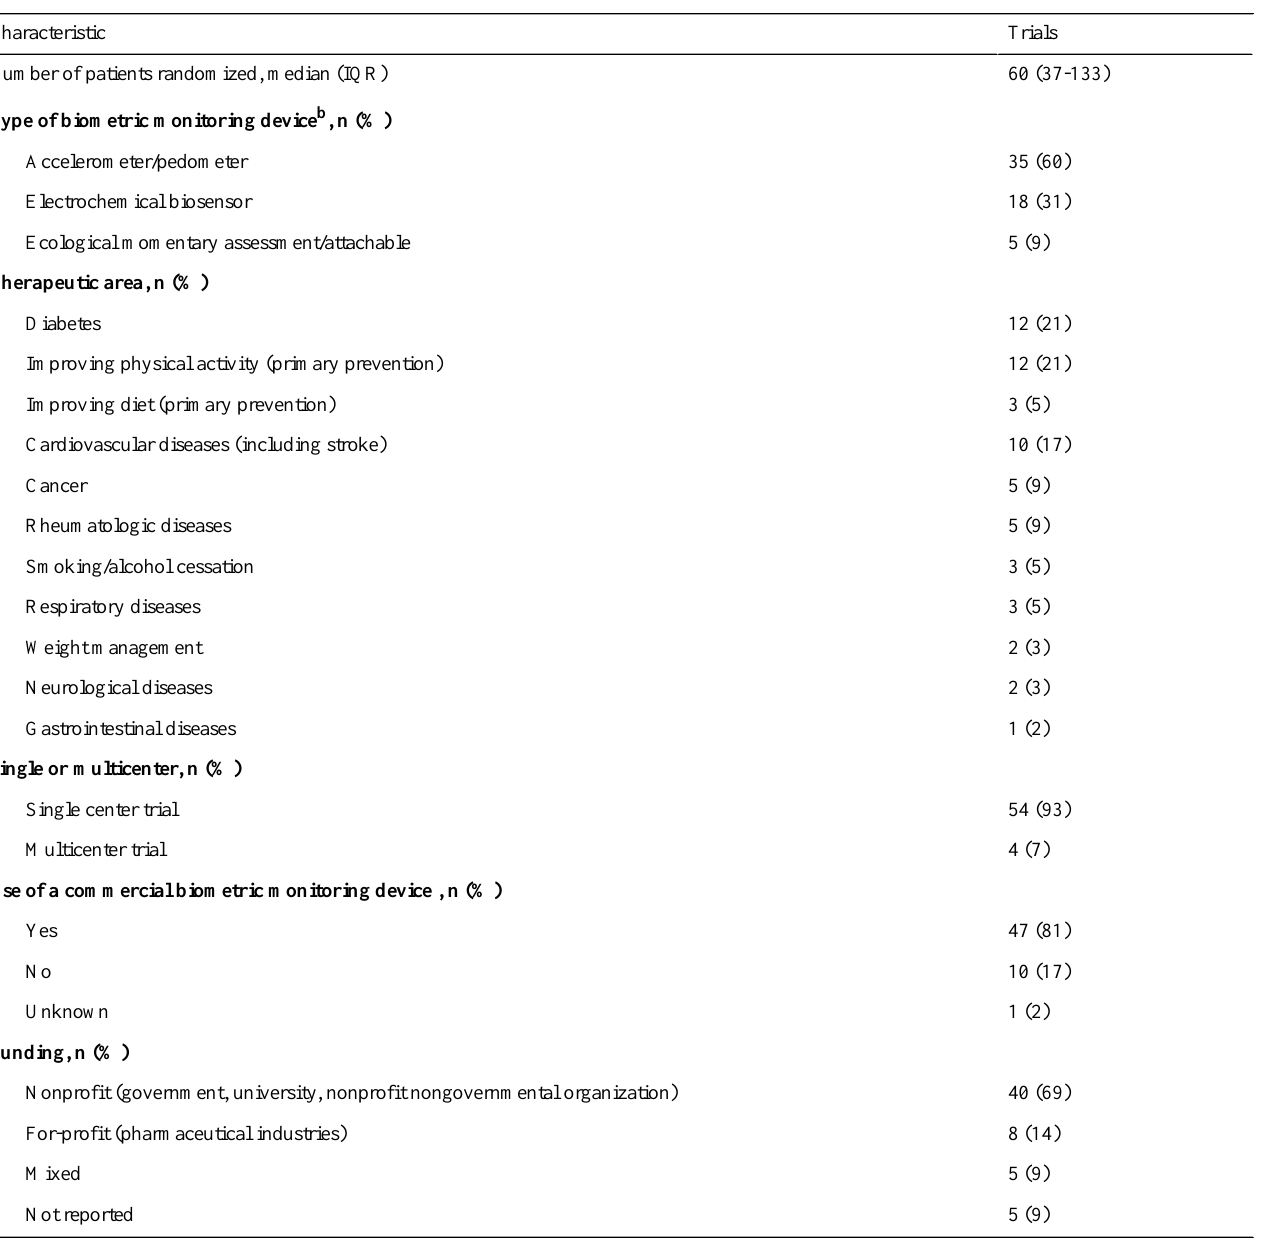
Table 1. Characteristics of the 58 included trials (N=58) a .